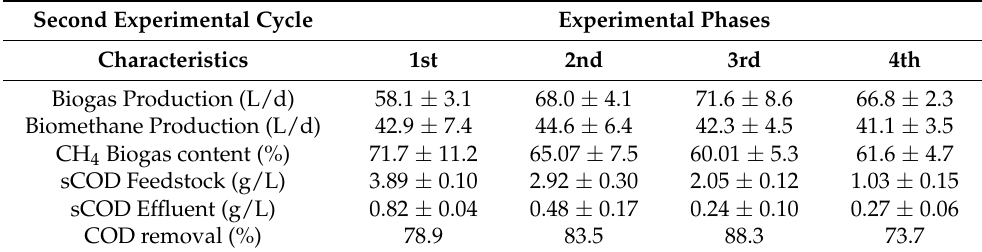
Table 6 . Average daily results of the second experimental cycle phases. Table 6. Average daily results of the second experimental cycle phases.